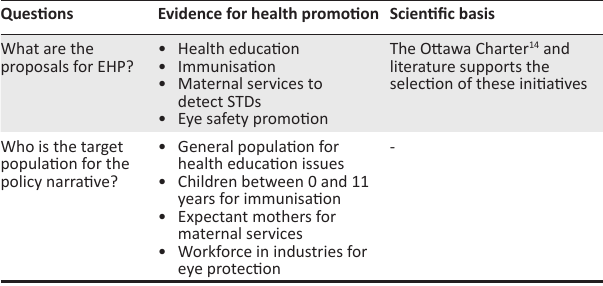
TABLE 1: Analysis of the guideline on prevention of blindness in South